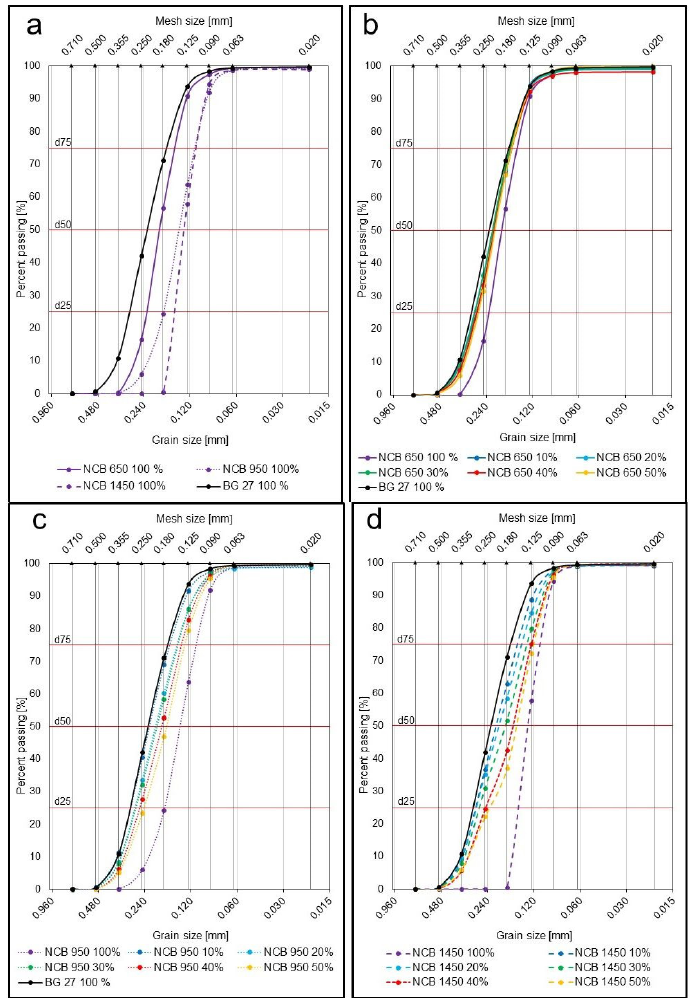
Figure 4. Detailed cumulative curves of granularity for individual NCB types compared with BG 27 100%: ( a ) 100% content of all sands. ( b ) NCB 650 addition. ( c ) NCB 950 addition. ( d ) NCB 1450 ad- dition.